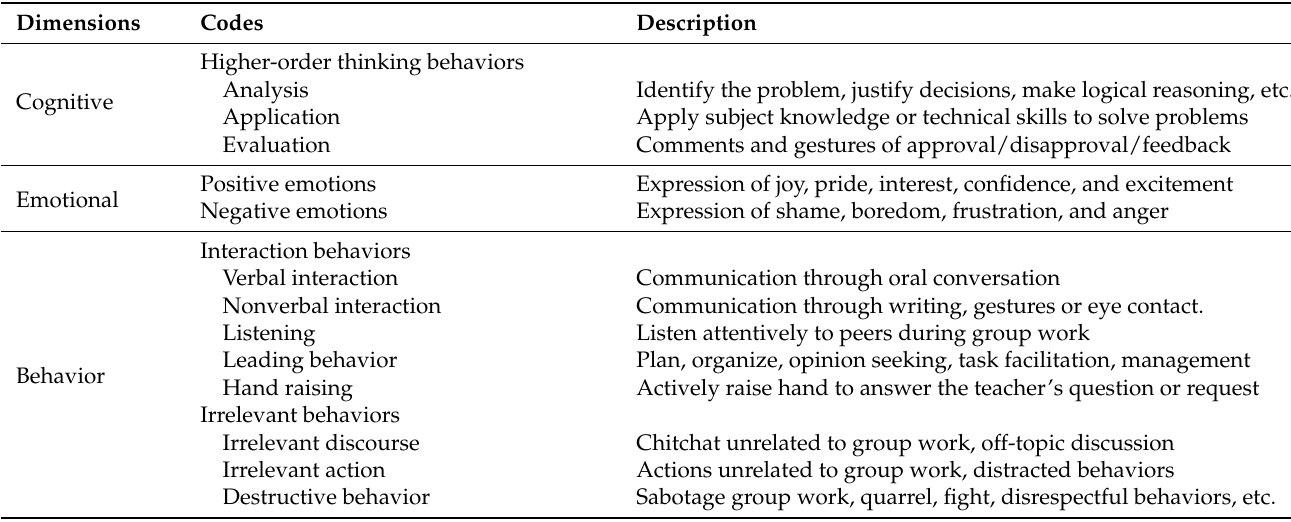
Table 2. Coding protocol used in this